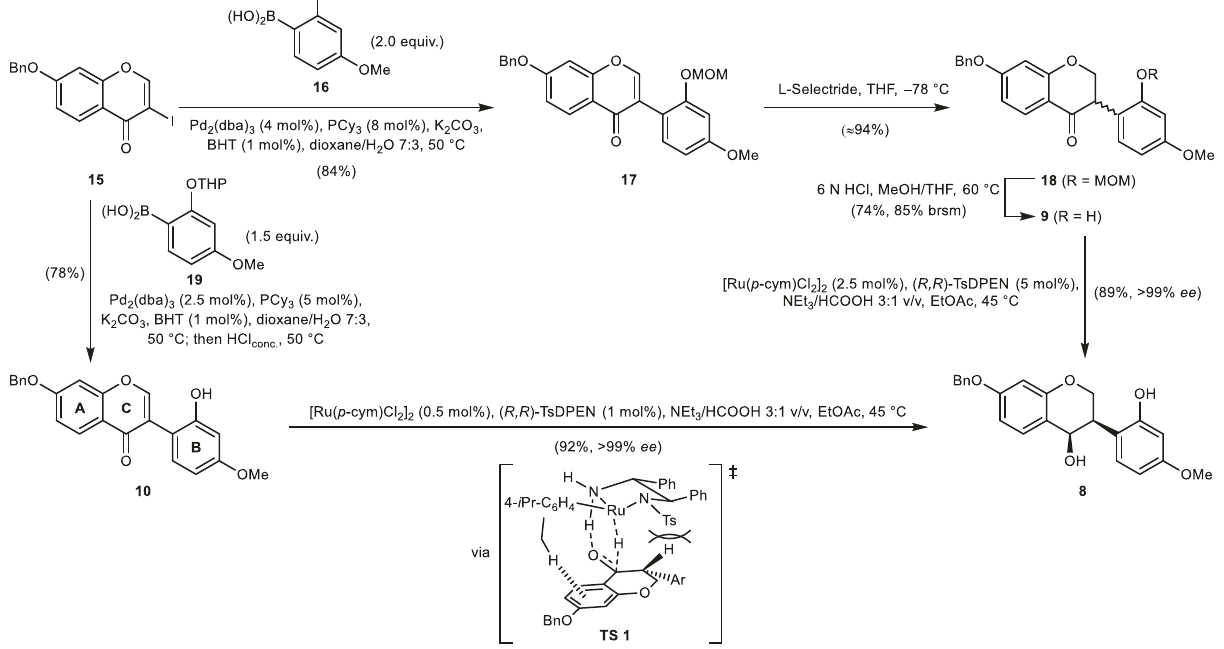
Fig. 3 Synthesis of iso fl avanol 8. Four-step approach to 8 via ATH of 2 ′ -hydroxyiso fl avanone 9 and optimised two-step synthesis of 8 via ATH of iso fl avone 10